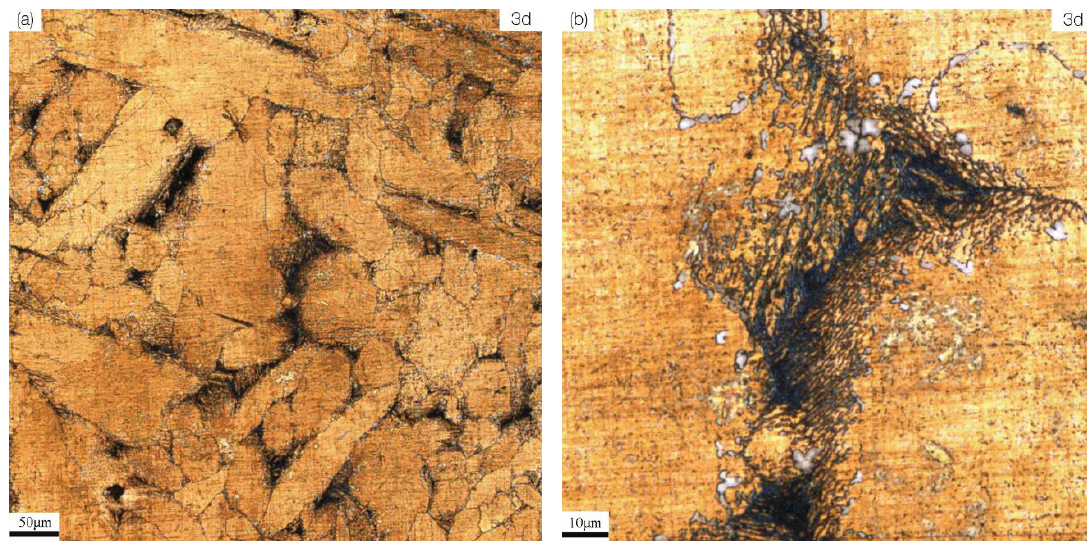
Figure 5. Surface and point scan of S-Defect before corrosion.